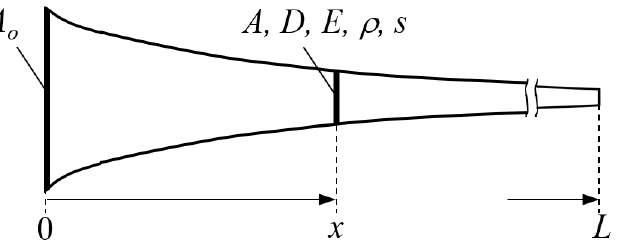
Figure 6. 1D waveguide with coordinate x [m] and 0 < x < L for the description of a traveling longitudinal wave in the + x direction; cross-section area A [m 2 ] (characteristic diameter D [ m ]= elasticity modulus E , density ρ , local displacement s and waveguide length L